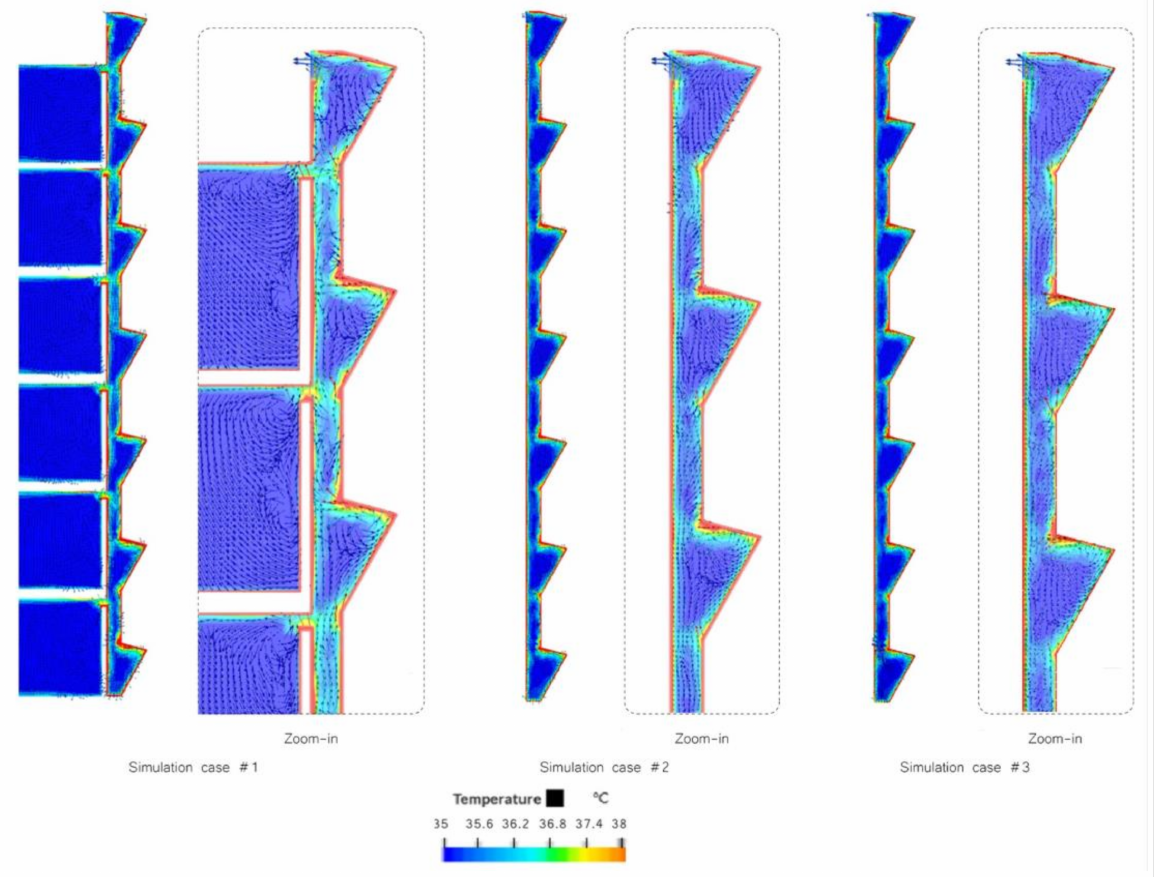
Figure 26. Convective heat transfer analysis simulation results for the summer